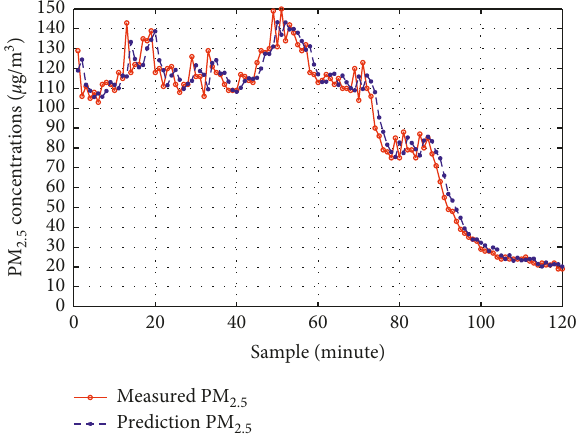
Figure 5: PM 2.5 concentration prediction result of model 1